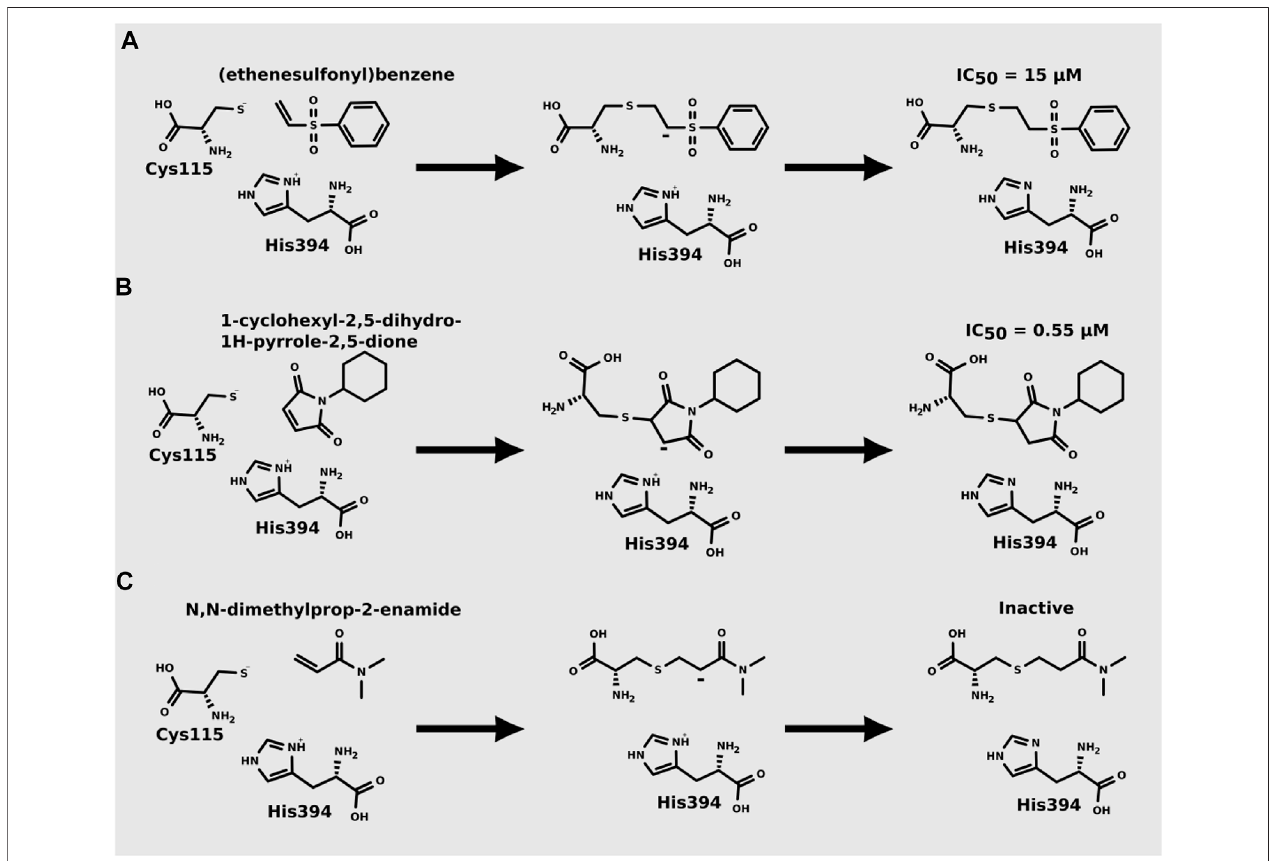
FIGURE 3 | Mechanism for the Michael addition of (A) (ethenesulfonyl)benzene (B) N,N-dimethylprop-2-enamide, and (C) 1-cyclohexyl-2,5-dihydro-1H-pyrrole- 2,5-dione against MurA ( E. coli ).